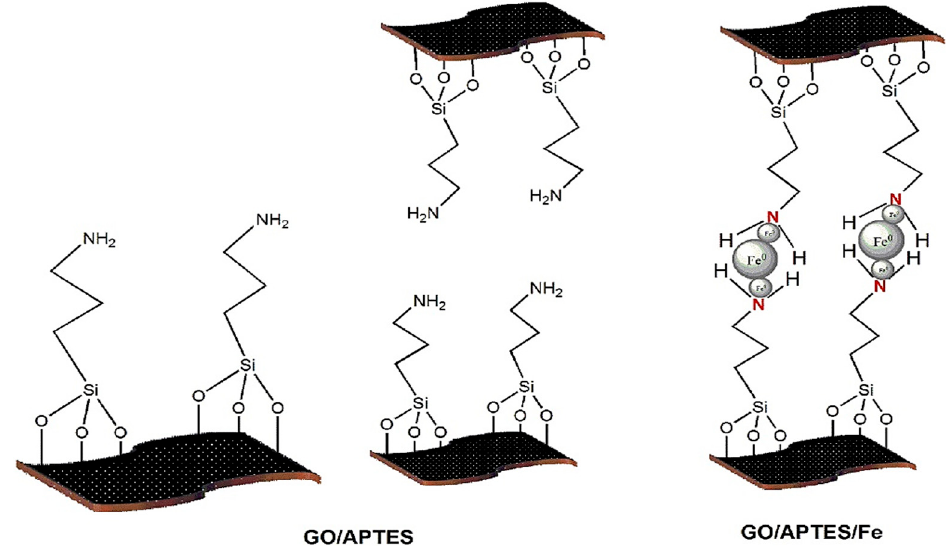
Figure 5. APTES for the stabilization and immobilization of iron nanoparticles onto GO adsorbent. Reprinted from [24] with permission from Elsevier.